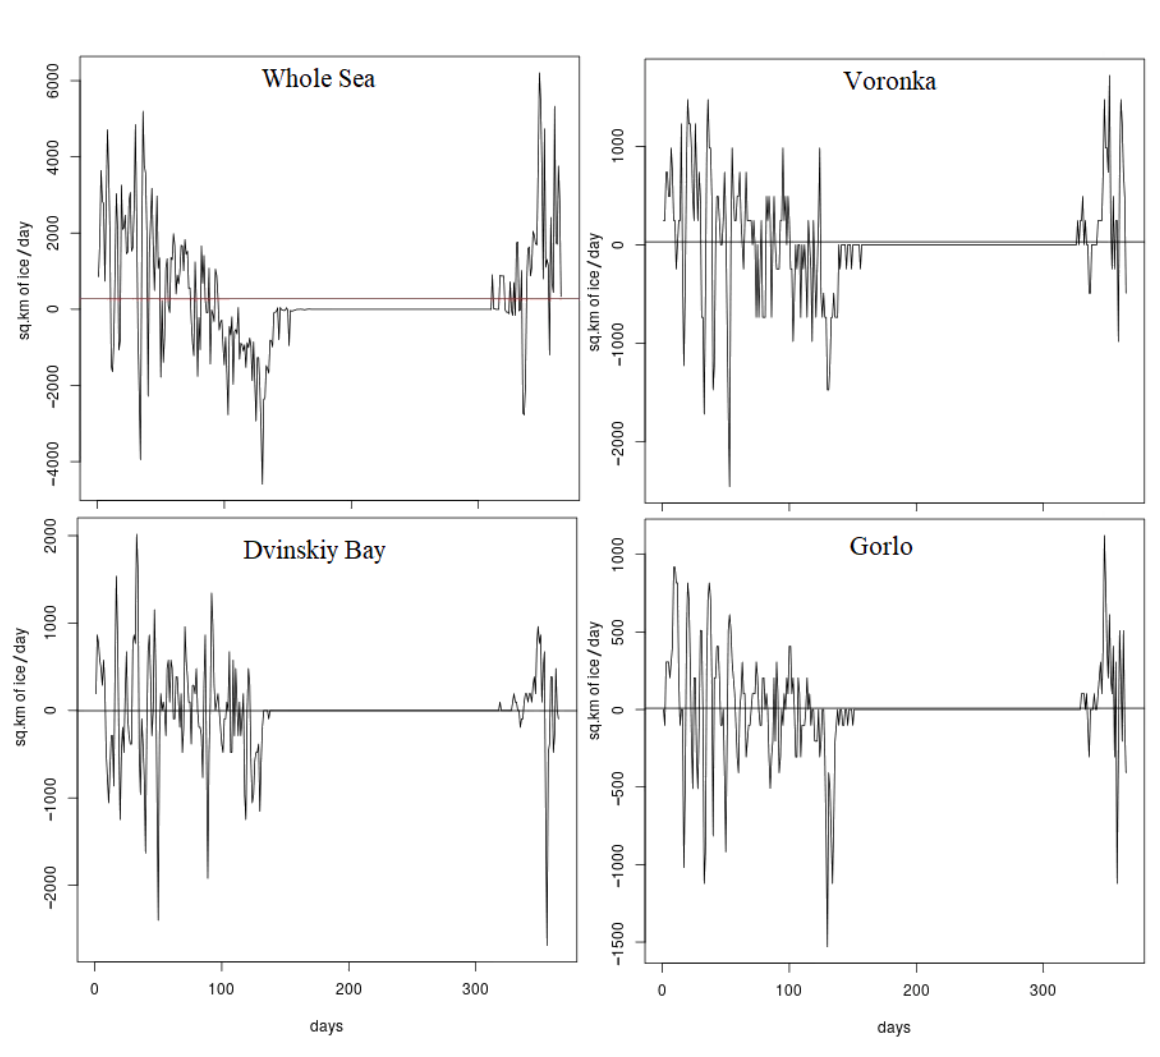
Figure 3. Freezing and melting of ice in the sea region during a year, km 2 /day.